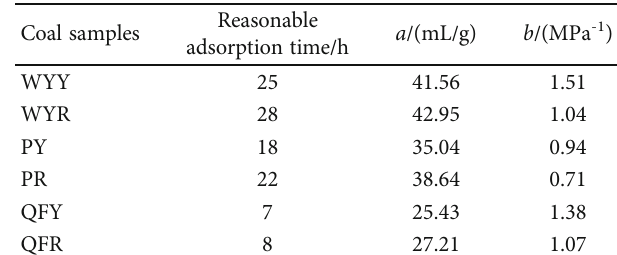
Table 7: Langmuir constants a and b at reasonable adsorption time.